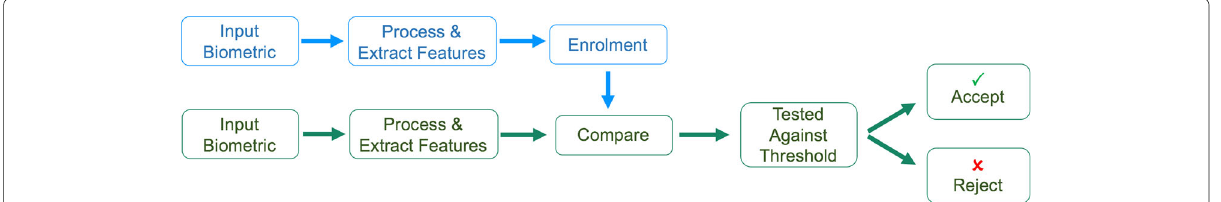
Fig. 1 Biometric authentication overview, involving an enrolment stage shown in blue, and authentication stage shown in green